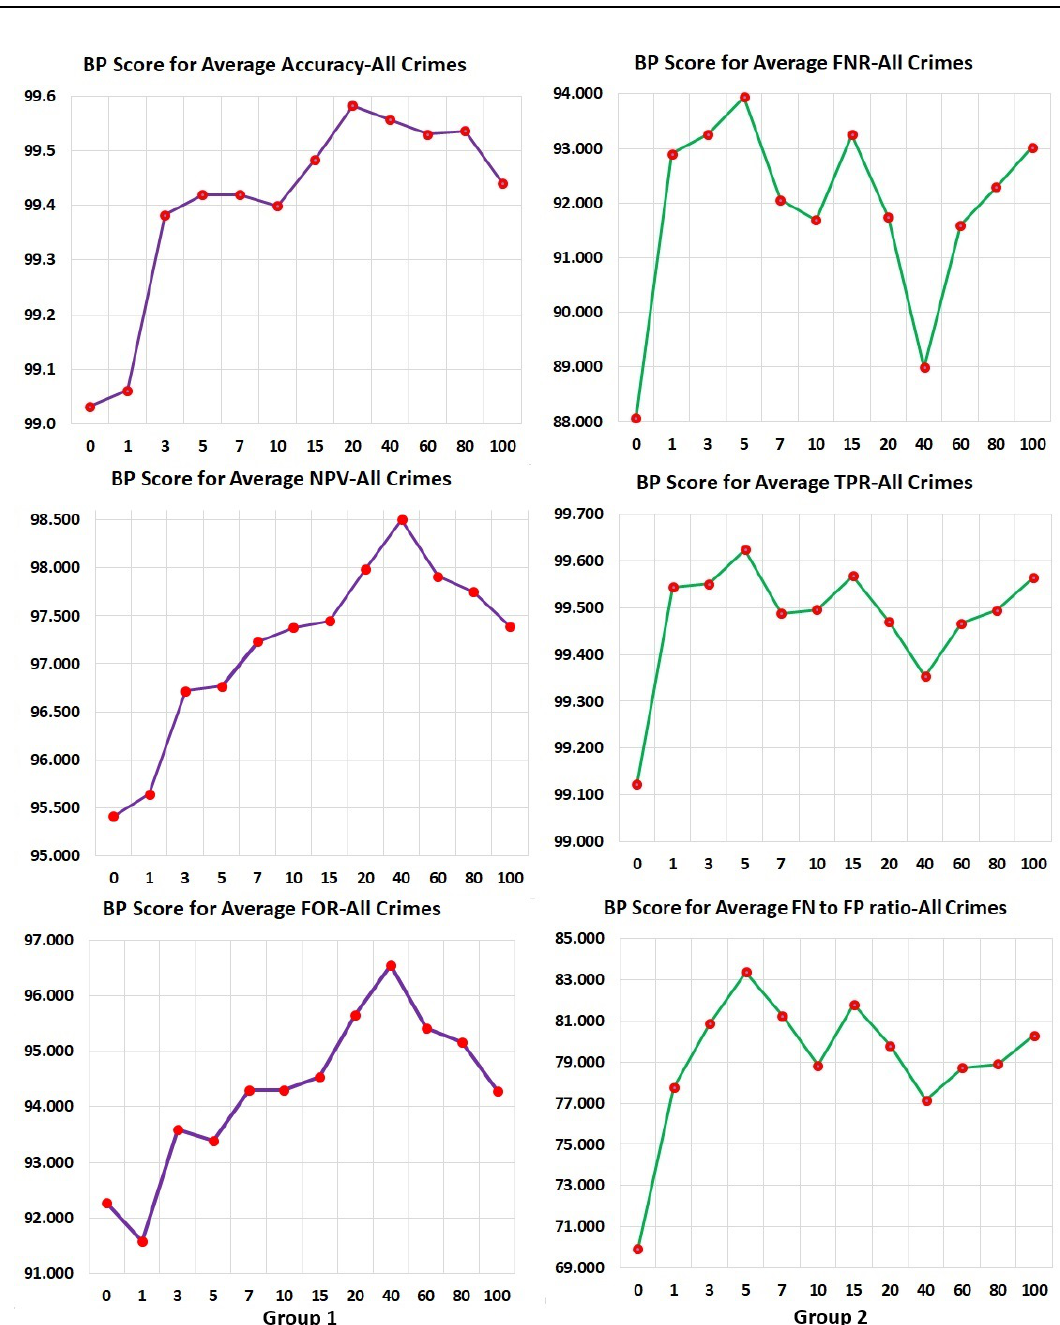
Figure 1. Bias Parity Score (BPS) by number of past arrest-release cycles (0, 1, 3, 5, 7, 10, 15, 20, 40, 60, 80, 100). Group 1 : BPS-Avg. Accuracy, BPS-Avg. Negative Predicted Value, BPS-Avg. False Omission Rate. Group 2 : BPS-Avg. False-Negative rate, BPS-Avg. True-Positive Rate, BPS-Avg. FN-to-FP-ratio. Averages : Computed using 10 iterations of Monte Carlo